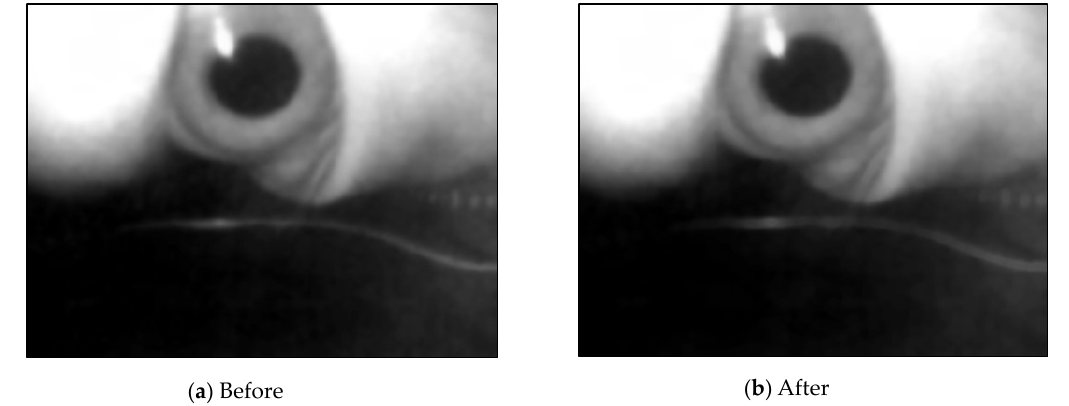
Figure 16. Image after applying mathematical morphological process.